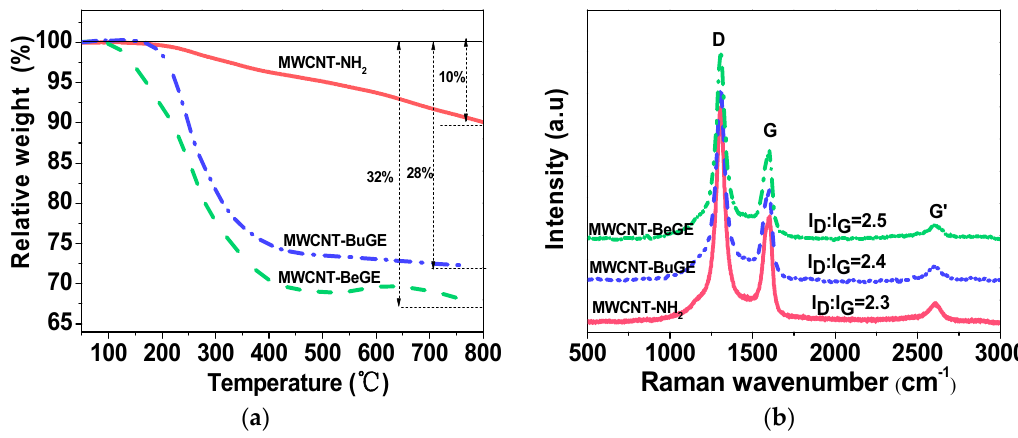
Figure 7. Thermogravimetric analysis (TGA) ( a ) and Raman spectra ( b ) of MWCNT-NH 2 , MWCNT-BuGE and MWCNT-BeGE.